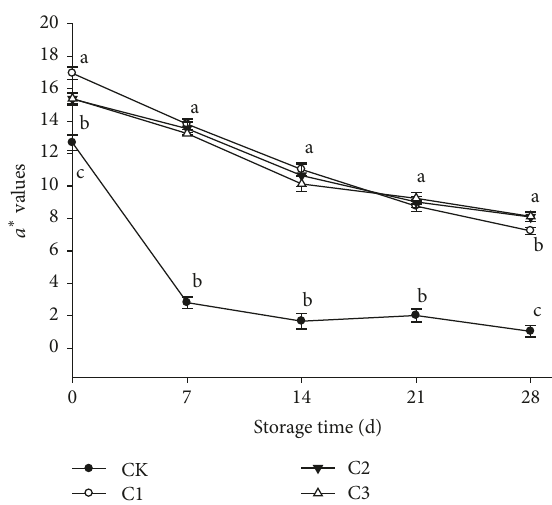
Figure 1: Changes in 𝑎 ∗ values of beefsteaks with different treatments during storage. CK, the group of beefsteaks without pretreatments; C1, the group of beefsteaks pretreated with 100%CO for 1.5h; C2, group of beefsteaks pretreated with 100% CO for 1.5 h and soaked in 50 mg/L ClO 2 ; C3, group of beefsteaks pretreated with 100% CO for 1.5h and soaked in 50 mg/L ClO 2 for 10min and sprayed with 30 g/L lactic acid. Data were represented with mean values ± Standard Error; sometimes the bars were too small to see. Different letters mean significant difference of samples with different treatments on the same storage days ( 𝑃 < 0.05 ). Three separate steaks of each treatment were measured; three repetitions were performed for each treatment. 𝑛 = 9